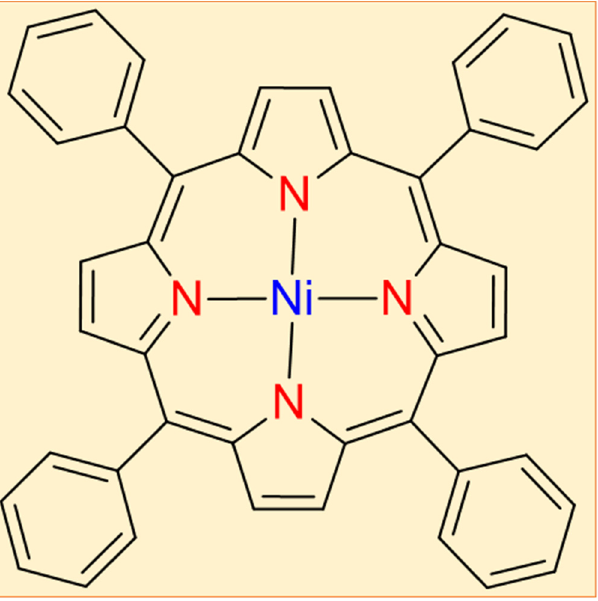
Figure 1. 5,10,15,20-tetraphenylporphyrinatonickel(II) (TPPNi) chemical structure.